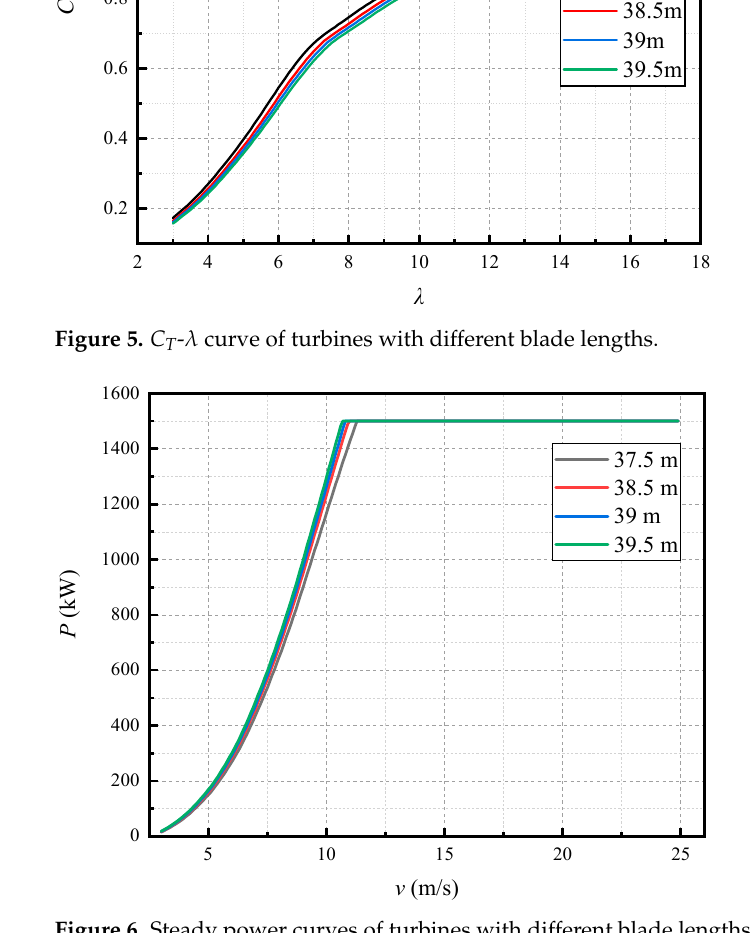
Figure 5. C T - λ curve of turbines with different blade lengths.